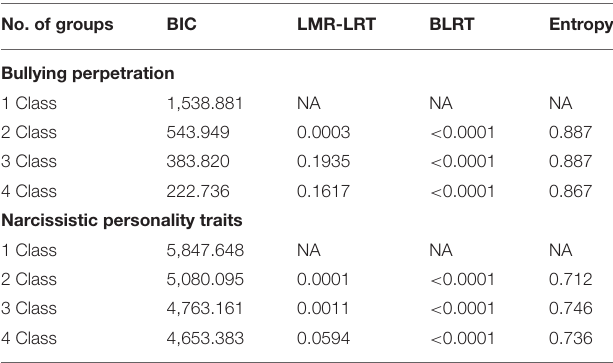
TABLE 2 | Fit indices for latent class trajectory models for bullying perpetration and narcissistic personality